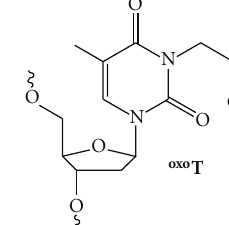
rupture of covalent bonding under reduction